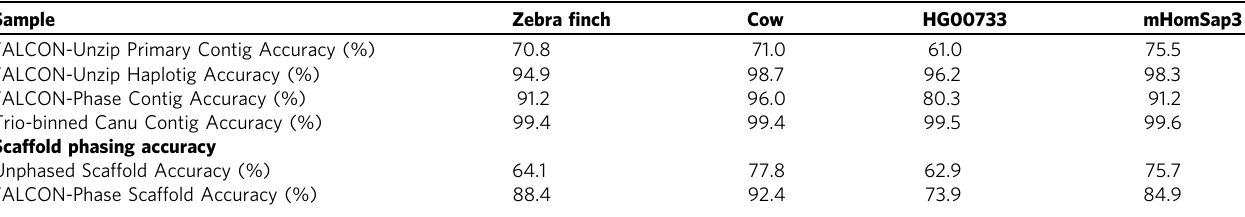
Table 2 FALCON-Phase